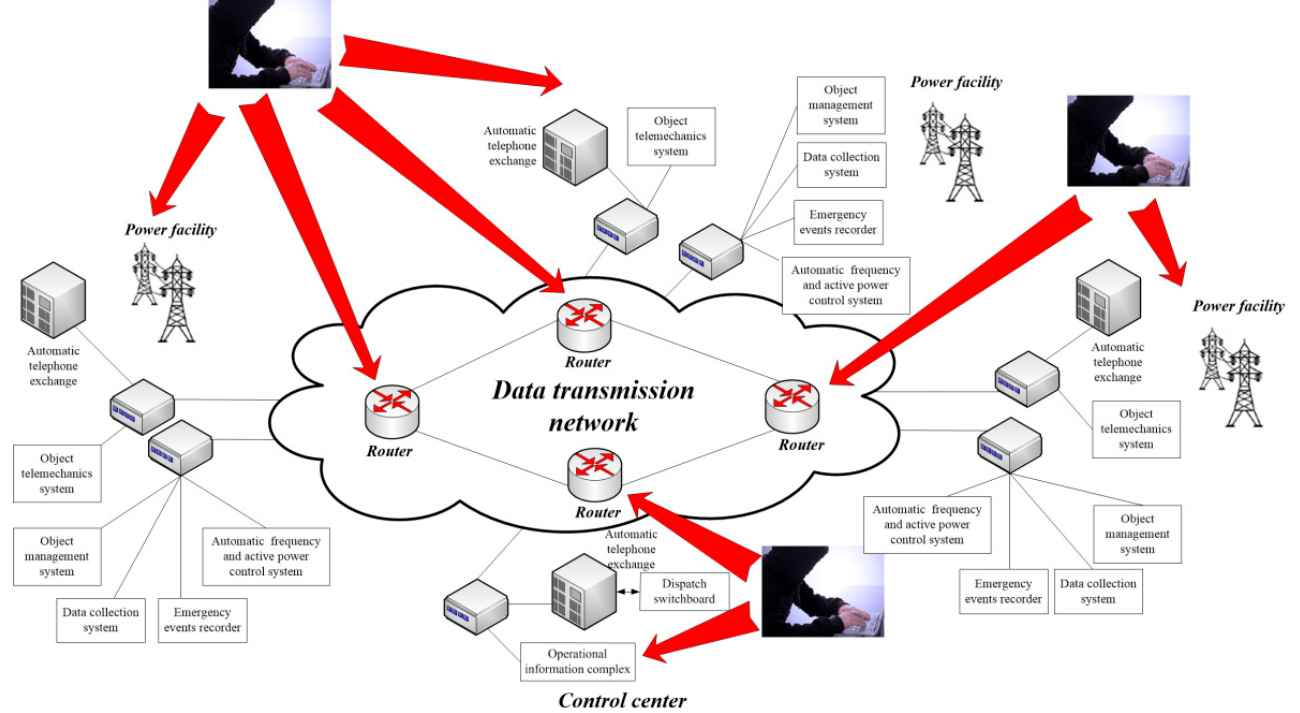
Figure 1. The location of the technological data transmission network in the branch electric power complex.